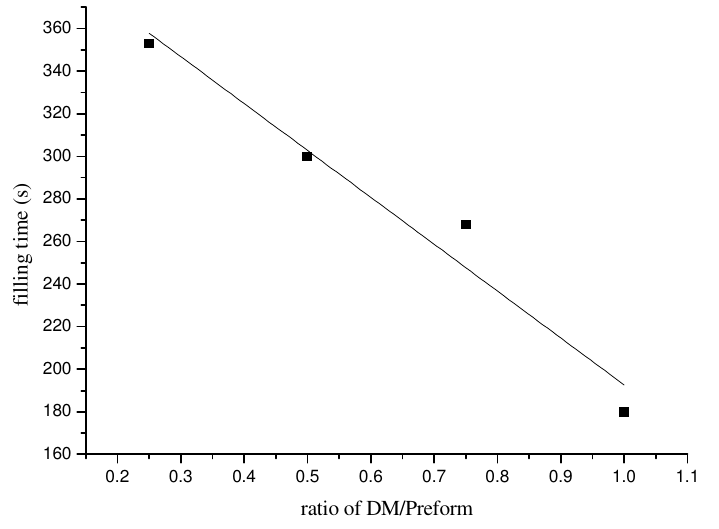
Figure 3. Relationship of filling time and ratio of DM/Preform.